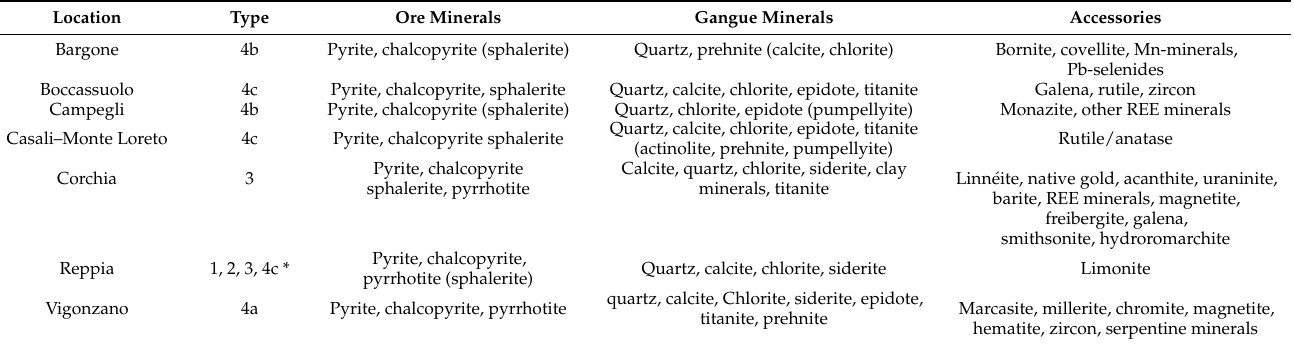
Table 1. Mineral assemblage of the studied VMS deposits, based on the research of [13,18] and own observations.